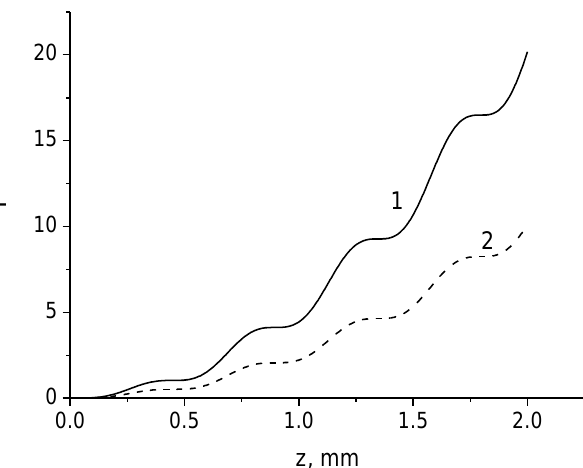
(cid:0) (cid:1) Figure 3. The values F = 10 5 4det J / Sp 2 J as a function of the distance at x 0 = 15 µ m for both ( ) 5 2 10 4 det / F J Sp J = as a function of the distance at x 0 = 15 μ m for both Figure 3. The values meridional and sagittal rays (solid curve 1) and only for meridional rays (dashed curve 2). meridional and sagittal rays (solid curve 1 ) and only for meridional rays (dashed curve 2). The degree of polarization decreases with increasing distance, and